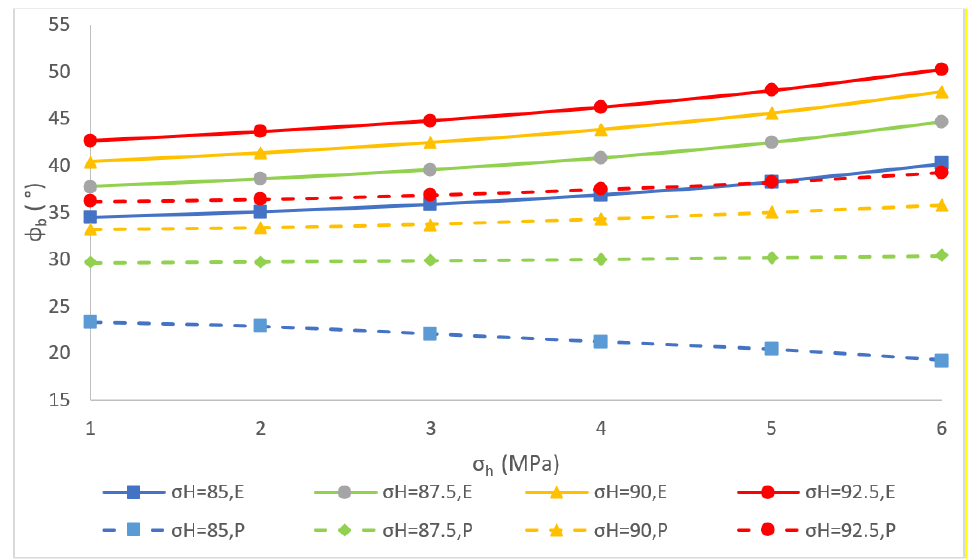
Figure 11. Comparison of breakout width between thermoporoelastic and thermoporoelastoplastic model.